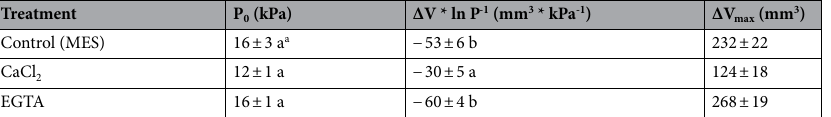
Table 8. Effects of CaCl 2 (10 mM) and EGTA (5 mM) on in vitro swelling pressure (P 0 ), the change in cell wall volume per unit pressure (ΔV * ln P -1 ) and the maximum volume after swelling at 0.2 kPa (ΔV max ) of cell walls of mature ‘Burlat’ sweet cherry fruit. Cell walls were extracted as the alcohol insoluble residue (AIR). All solutions were buffered using 10 mM MES. Buffer only served as control. The swelling pressure was calculated as the extrapolated x-axis intercept of a linear regression fitted through a plot of the change in AIR volume vs. the natural logarithm of the applied pressure (ln P). The change in AIR volume per unit pressure represents the slope of this regression and may be interpreted as the volumetric modulus of elasticity of the AIR. The pH of each solution was adjusted to pH 5.8 using KOH or HCl. Data are means ± SE. a Mean separation within columns, Tukey’s Studentized range test at p <